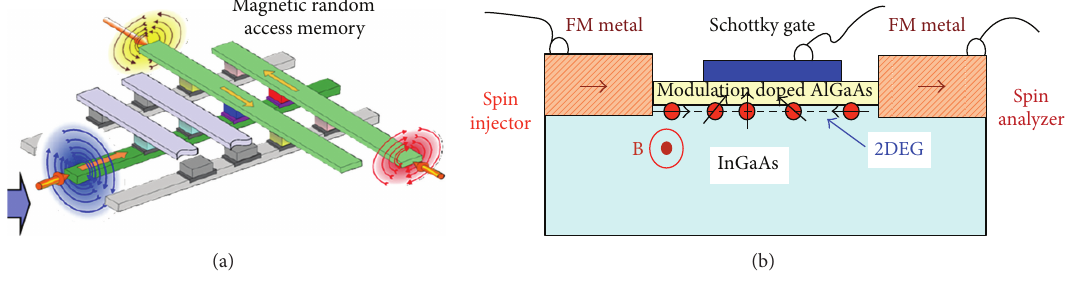
Figure 12: (a) Magnetic radom access memory (IBM), (b) spin transistor.